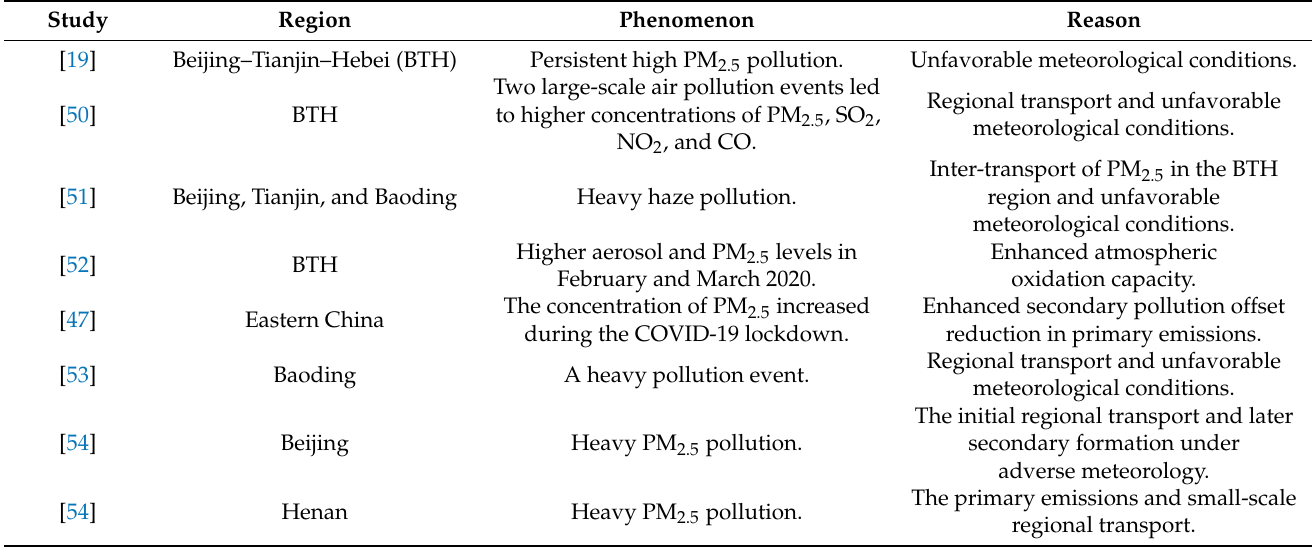
Table 2. Summary of studies related to the causes of air pollution events during